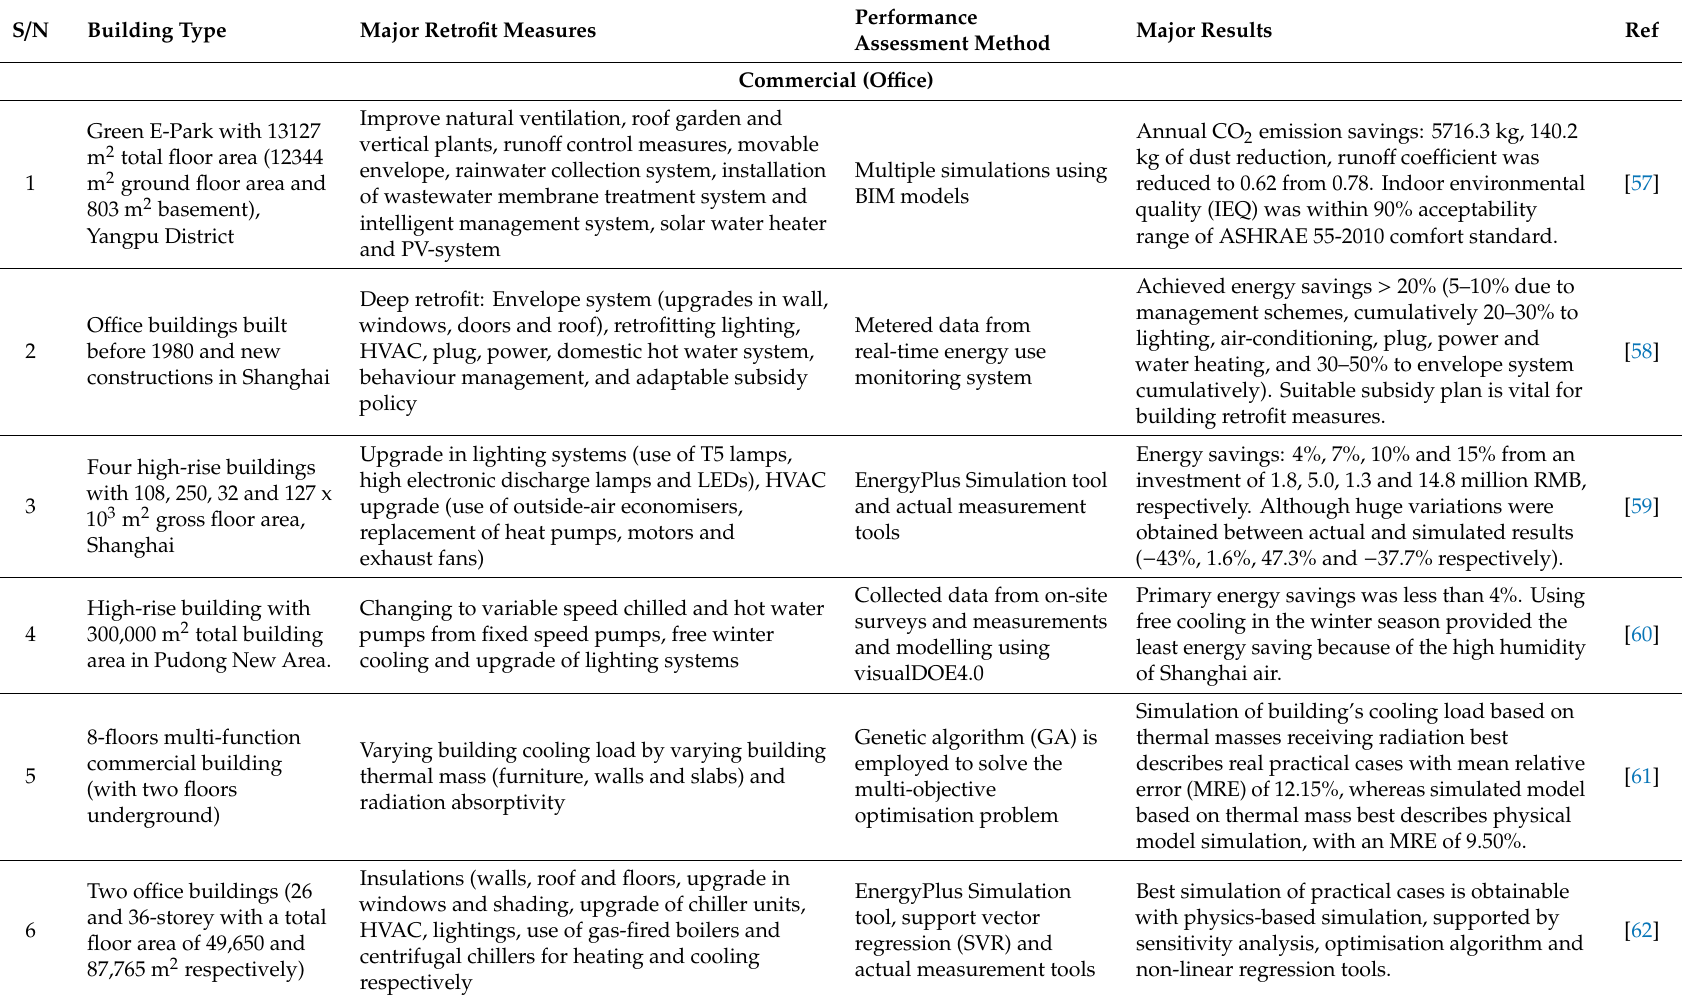
Table 4. Summary of various studies on building retrofit measures in